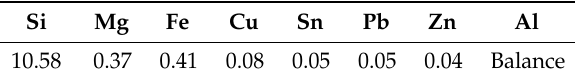
Table 2. Processing parameters for the selective laser melting (SLM) of AlSi10Mg samples.